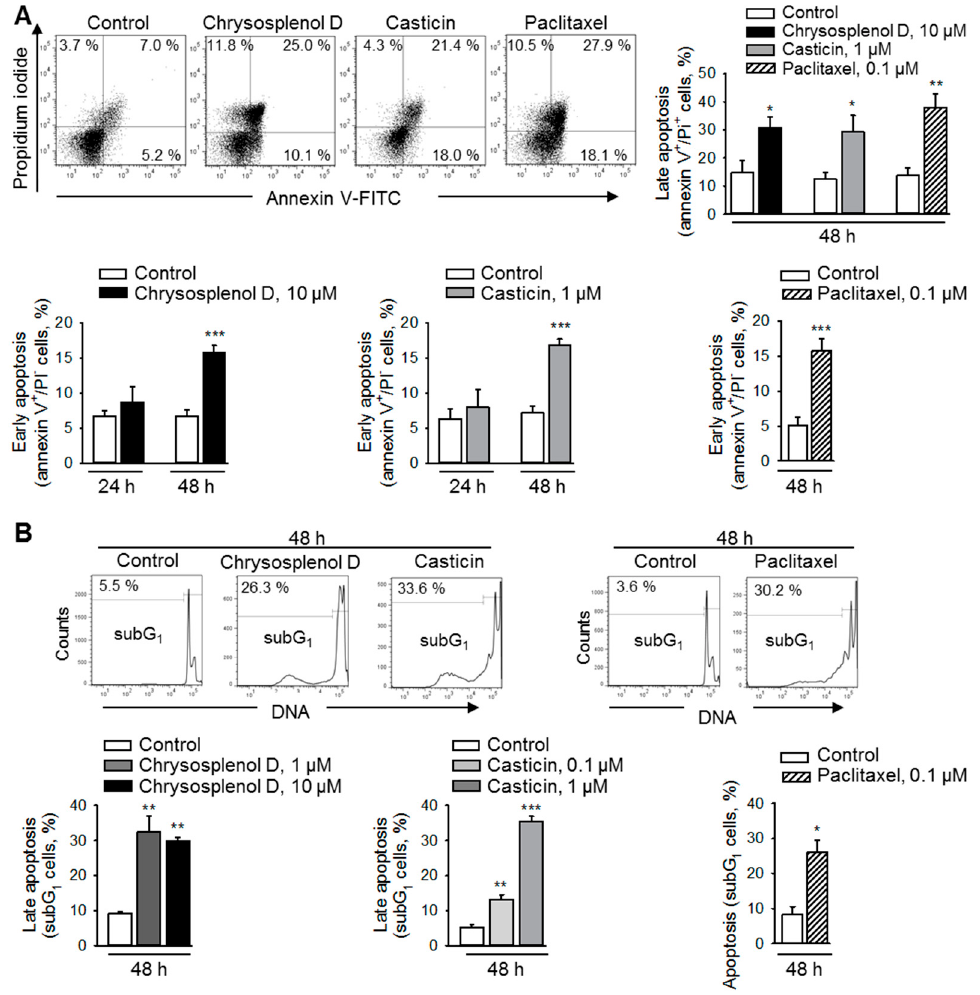
Figure 4. Chrysosplenol D and casticin induce apoptosis in breast cancer cells. ( A ) MDA-MB-231 cells were treated with chrysosplenol D , casticin, or paclitaxel (100 nM), stained with annexin V- fluorescein isothiocyante (FITC)/propidium iodide, and analyzed by flow cytometry. Early apoptotic cells (annexin V+/PI- cells) and late apoptotic cells (annexin V+/PI+) are shown. Representative dot blots after 48 h of treatment with chrysosplenol D (10 µM), casticin (1 µM), or paclitaxel (100 nM) are shown, n = 3–5. ( B ) Cells were treated as described in ( A ). DNA was stained with propidium iodide and analyzed by using flow cytometry, n = 3. Data are mean ± SEM, * p < 0.05, ** p < 0.01, *** p < 0.001 vs controls.